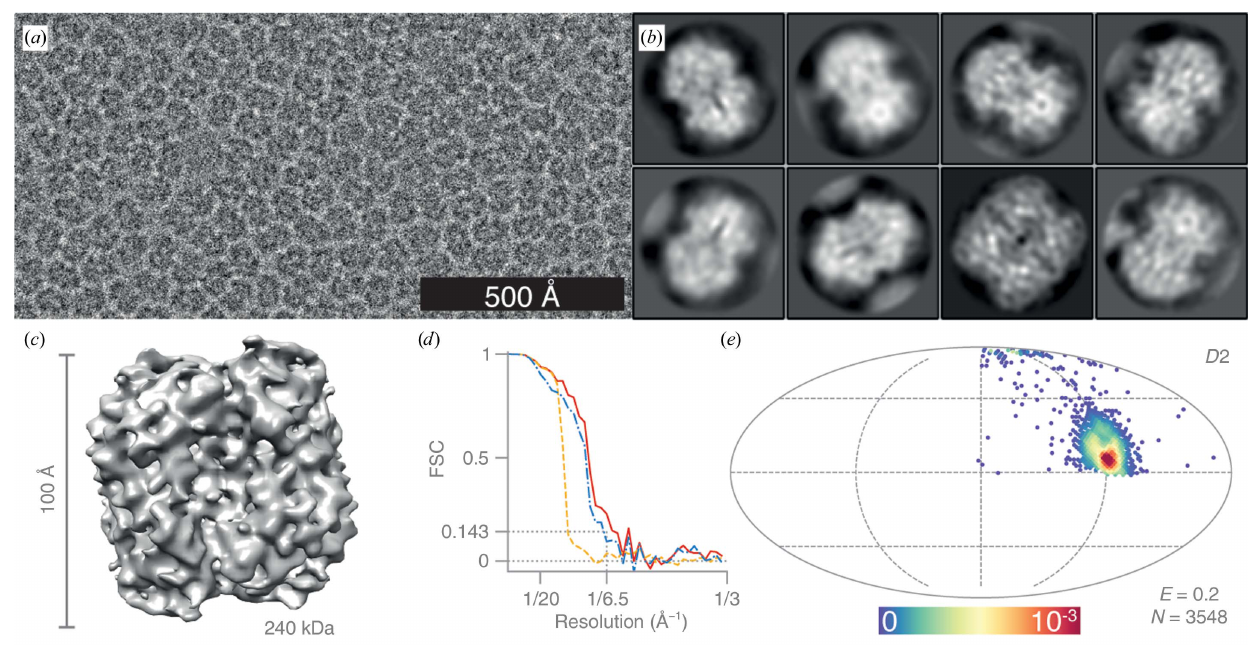
Figure 7 Structure of catalase determined at 100 keV. ( a ) Typical micrograph after motion correction. Contrast is adjusted to (cid:8) 3 (cid:3) from the mean intensity. ( b ) 2D class averages, showing mostly side views, except for a single class showing the strongly under-represented top view. ( c ) Sharpened masked 3D reconstruction of catalase from N = 3548 particles with dihedral ( D 2) symmetry. ( d ) Gold-standard FSC plot corresponding to the calculated map, showing the correlation between the phase-randomized (yellow), unmasked (blue) and masked (red) half-maps. The plot terminates at the Nyquist frequency. ( e ) Orientation distribution of the catalase particles contributing to the final reconstruction (Mollweide projection). All Euler angles are assigned within one asymmetric subunit for the D 2 symmetric particle. The colour scale (linear) corresponds to the normalized density of views (blue, low; red, high). E = 0.2 is the efficiency of the orientation distribution, indicating a strong orientation preference, which limits the resolution of the reconstruction.